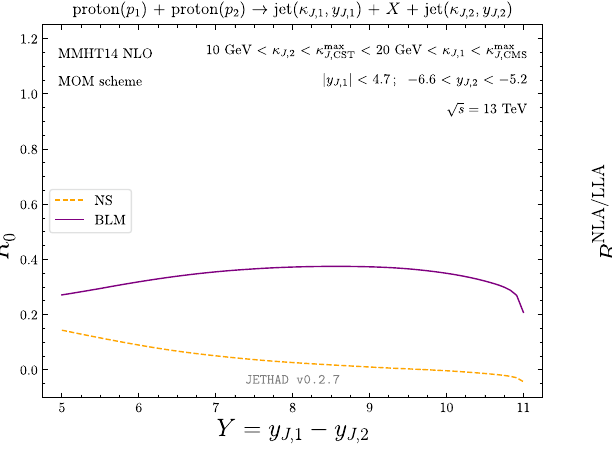
/ LLA ratio for the three considered √ 0 s = 13